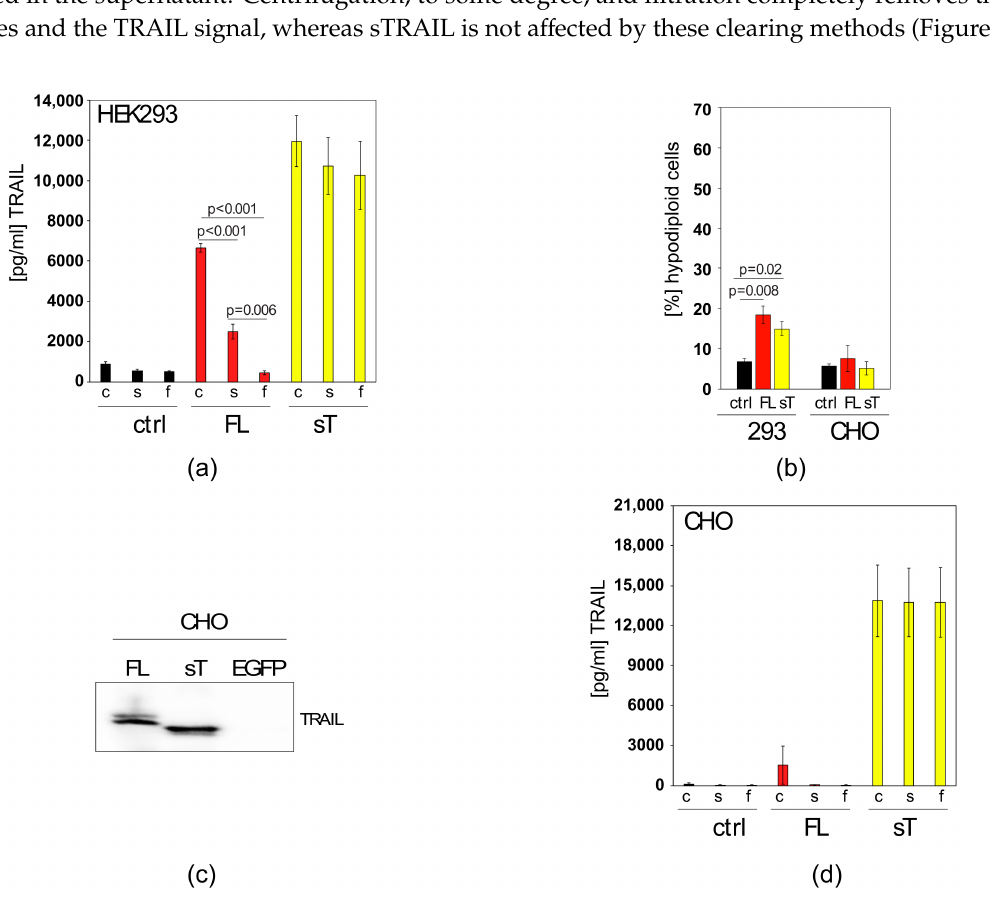
Figure 2. In apoptosis-sensitive, FL-TRAIL expressing cells, TRAIL appears in the supernatant owing to apoptosis, but not secretion ( a ) HEK293 cells were transfected with an empty plasmid (ctrl), a FL-TRAIL construct (FL) or an sTRAIL (sT) construct. The resulting medium supernatants were either taken as crude supernatants (c), centrifuged (s) or filtered through a 0.45 µ m filter (f) before TRAIL levels were measured by ELISA ( b ) Apoptosis was measured in HEK293 and CHO cells that were transfected with an empty plasmid (ctrl), an FL-TRAIL construct (FL) or an sTRAIL construct (sT). ( c ) CHO cells were transfected with pCDNA3 constructs expressing FL-TRAIL (FL), sTRAIL (sT) or EGFP. The resulting protein lysates were subjected to western blotting. The membrane was then probed with a TRAIL antibody. ( d ) CHO cells were transfected with an empty plasmid (ctrl), a FL-TRAIL construct (FL) or an sTRAIL (sT) construct. The resulting medium supernatants were either taken as crude supernatants (c), centrifuged (s) or filtered through a 0.45 µ m filter (f) before TRAIL levels were measured by ELISA. Values represent mean ±